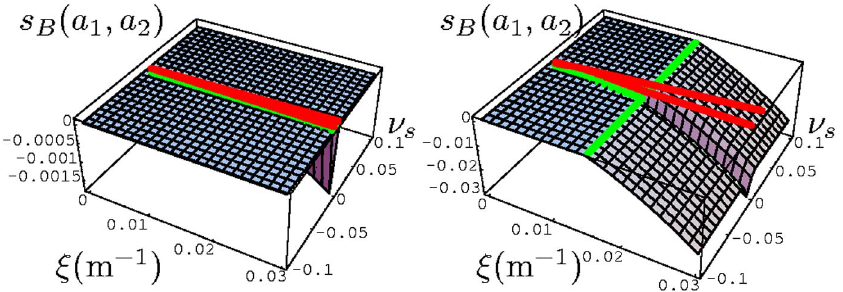
(cid:2) 0 ; right: (cid:22) (cid:2) 4 m . < 0 . Left: (cid:22) k k 2